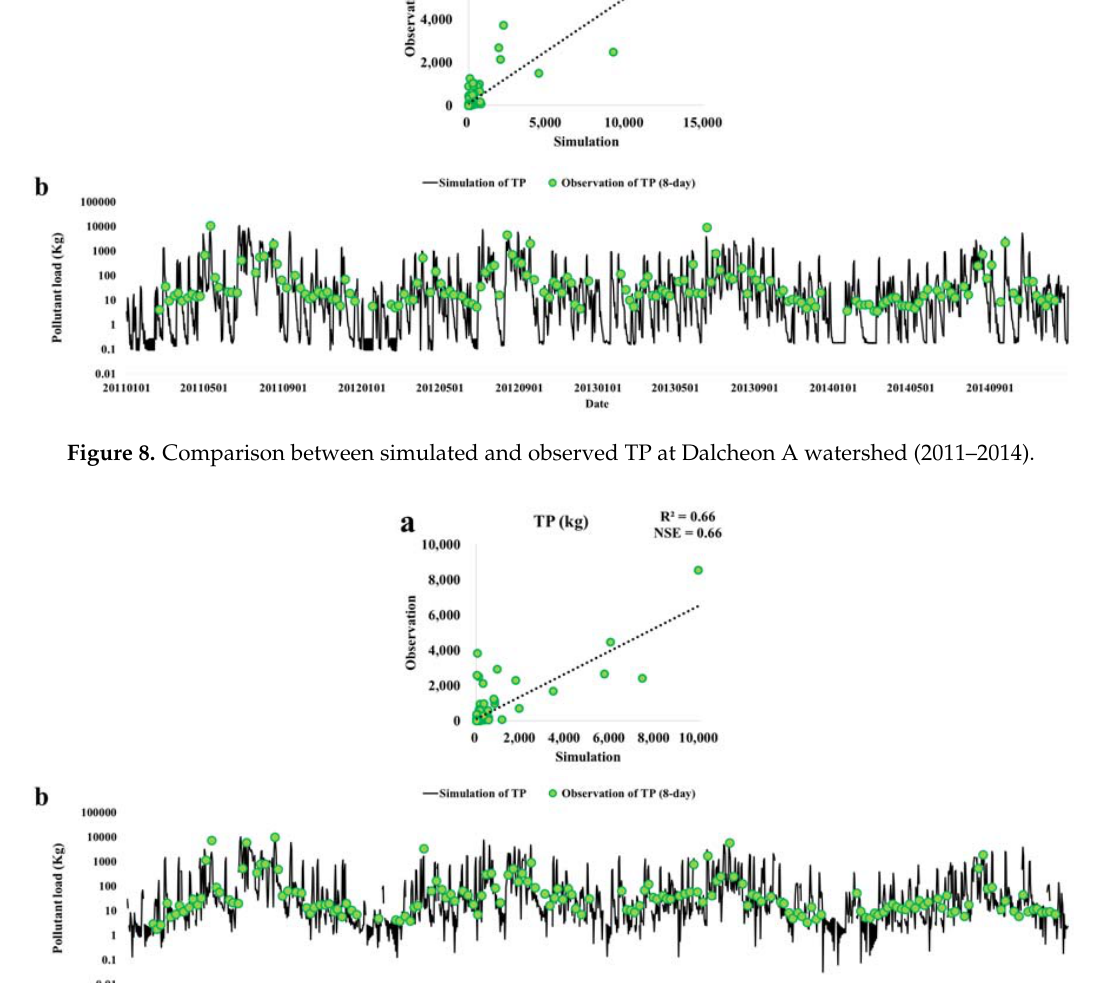
Figure 9. Comparison between simulated and observed TP at Pyungchang A watershed (2011–2014).